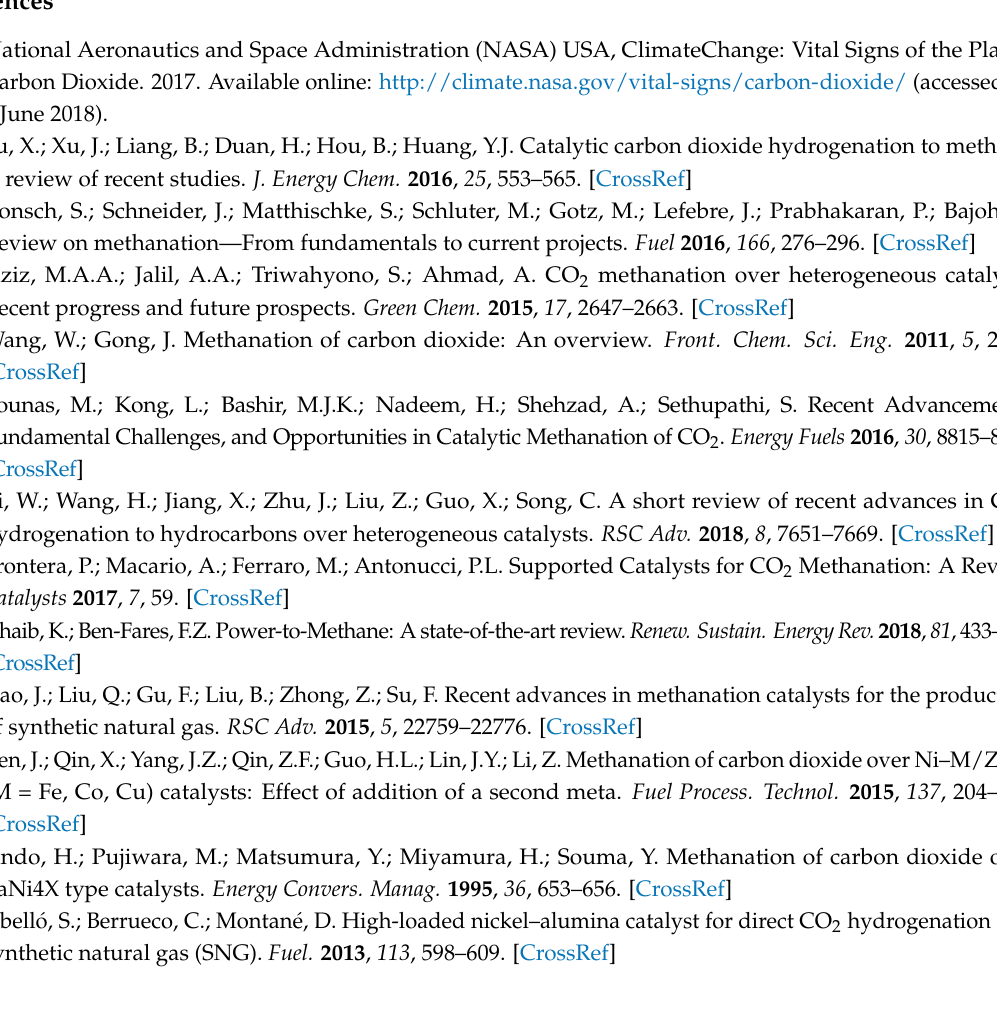
Table S1. Nickel catalysts reported for CO 2 hydrogenation at atmospheric pressure. Table S2. SEM microanalysis. Table S3. Peak areas of the hydrogen chemisorption analysis. Figure S1. Rietveld simulation for the sol-gel ZrO 2 support. Figure S2. Rietveld simulation for the co-precipitation ZrO 2 support. Figure S3. Effect on GHSV on CO 2 conversion with the 20% Ni/ZrO 2 -COP catalyst. Reaction conditions: 400 ◦ C, 0.1 MPa. Figure S4. SEM images of 20% Ni/ZrO 2 -COP